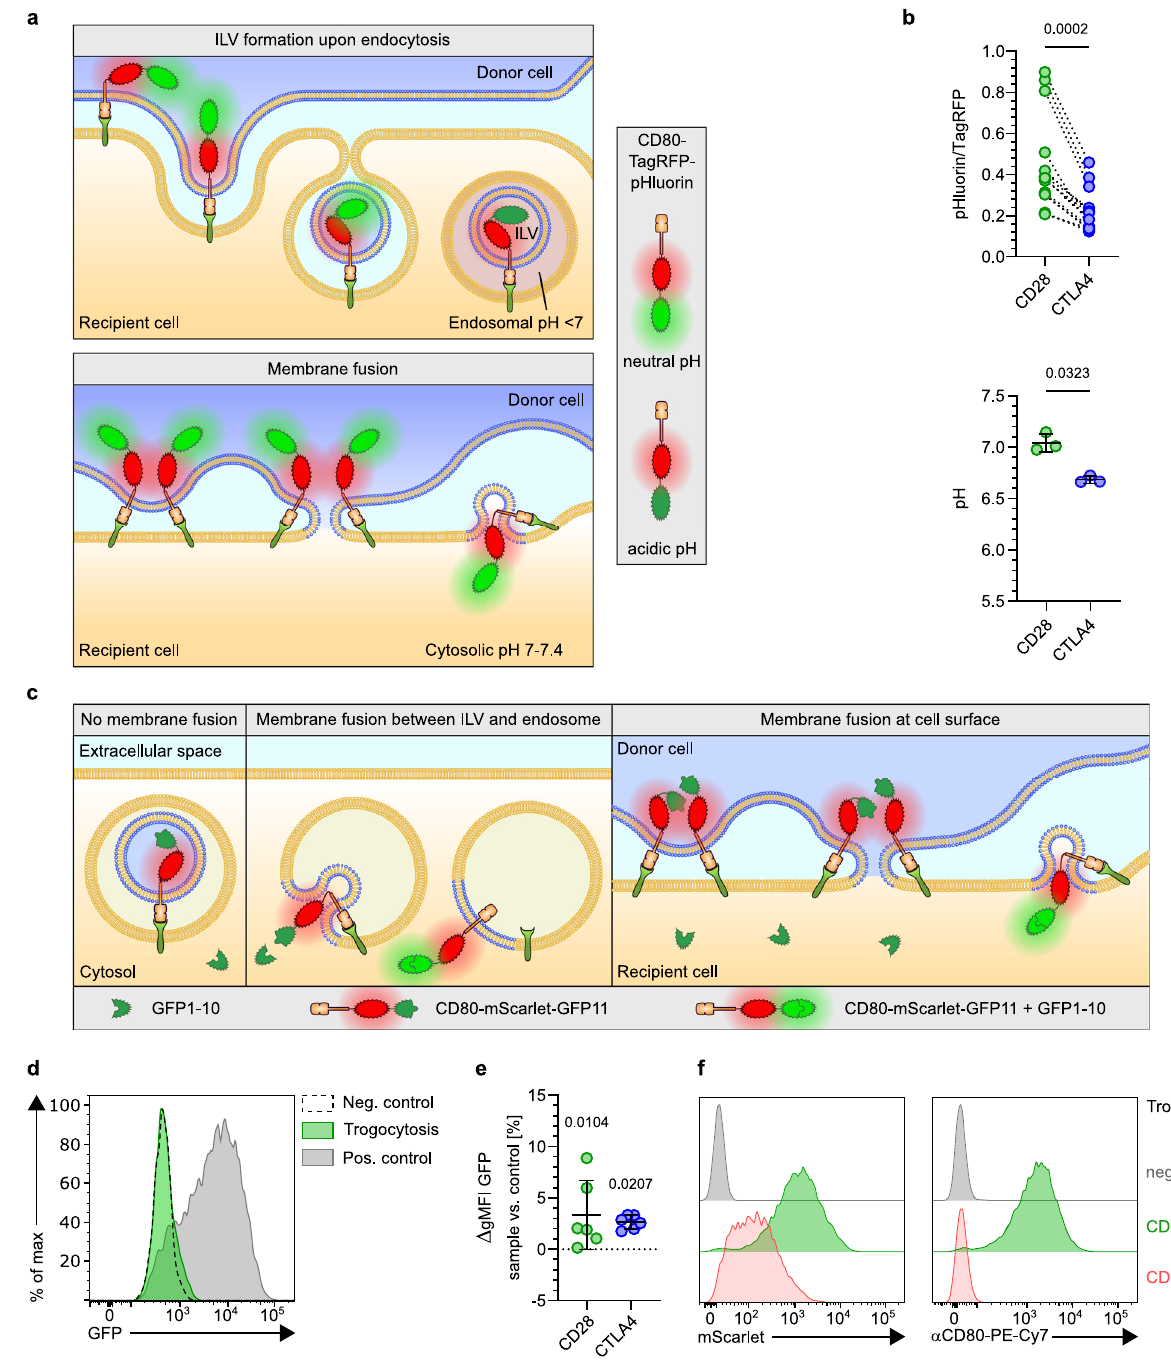
Fig. 4 | Dissecting mechanisms underlying trogocytosis. a Cartoons depicting putative mechanisms of trogocytosis via intraluminal vesicle (ILV) generation or membranefusionbetweendonorandrecipientcells. b CD80experiencesdifferent pH-levels upon trogocytosis via CD28 versus CTLA4. CD28- or CTLA4-expressing 58 αβ A2 T cells were co-cultured with CD80-TagRFP-pHluorin expressing CHO cells. Quanti fi cation of pHluorin/TagRFP ratio and extrapolation of pH-levels experienced by trogocytosed CD80 based on standard curve shown in Figure S3. c , d Analysis of membrane fusion by bi-molecular fl uorescence complementation (BIFC) assay. c Cartoon depicting putative outcomes of BIFC trogocytosis assay. CD8+ T cells ( d ) or CD28- or CTLA4-expressing 58 αβ A2 T cells ( e ) expressing cytosolic GFP1 – 10 were co-cultured with CD80-mScarlet-GFP11-expressing CHO cells. Positive control: GFP1 – 10 transgenic T cells transduced with CD80-mScarlet- GFP11 ( d ). Negative control: GFP1 – 10 transgenic T cells cultured with CD80- mScarlet-transgenic CHO cells. Plot shows increase of GFP gMFI over negative